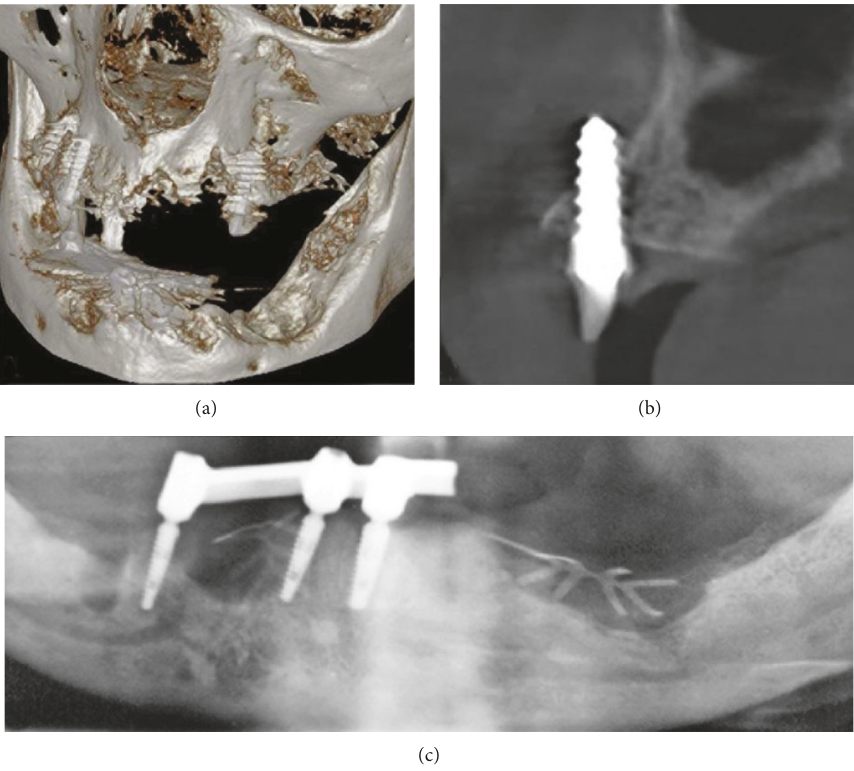
Figure 5: (a) Volumetric 3D representation of hard tissue and maxillary implants, taken during mandibular surgery, demonstrating large bone defects and loss of buccal bone plate in the maxilla. (b) Axial CBCT section of the maxilla showing misplaced implant #4. (c) OPG section showing bar retained on the remaining three mandibular implants (not modified radiograph taken during current treatment).